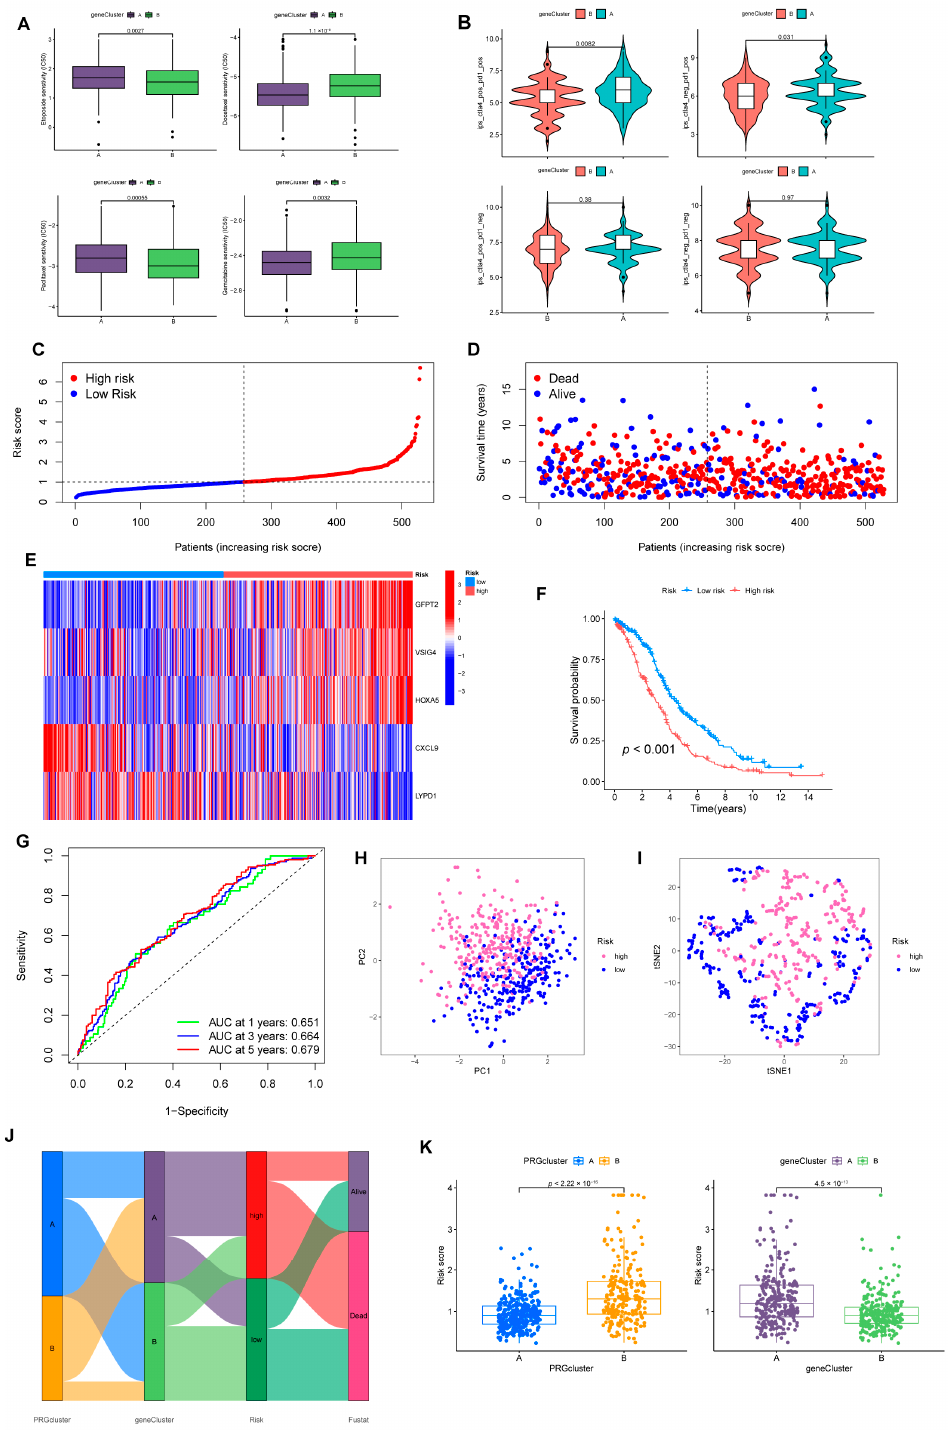
Figure 5. Construction of risk model associated with CRGs and FRGs . ( A ) Sensitivity of two gene- clusters to the chemotherapeutic drug commonly targeted OV. ( B ) Response of different clusters to immune checkpoint inhibitors. ( C ) Exhibition of a risk model in the entire cohort. ( D ) Overview of the survival time and status of the entire cohort between the two risk groups. ( E ) A heatmap of 5 hub genes expression in the entire cohort. ( F ) Differences in OS between different risk groups in the entire set. ( G ) ROC analysis predicts OS at 1, 3, and 5 years according to the risk score in the entire set. ( H ) PCA and ( I ) tSNE analysis results for different risk layers in the entire set. ( J ) Association with PRGcluster, gene cluster, risk score, and survival outcome. ( K ) Distribution profile of risk scores in different PRGsubtypes and gene clusters.